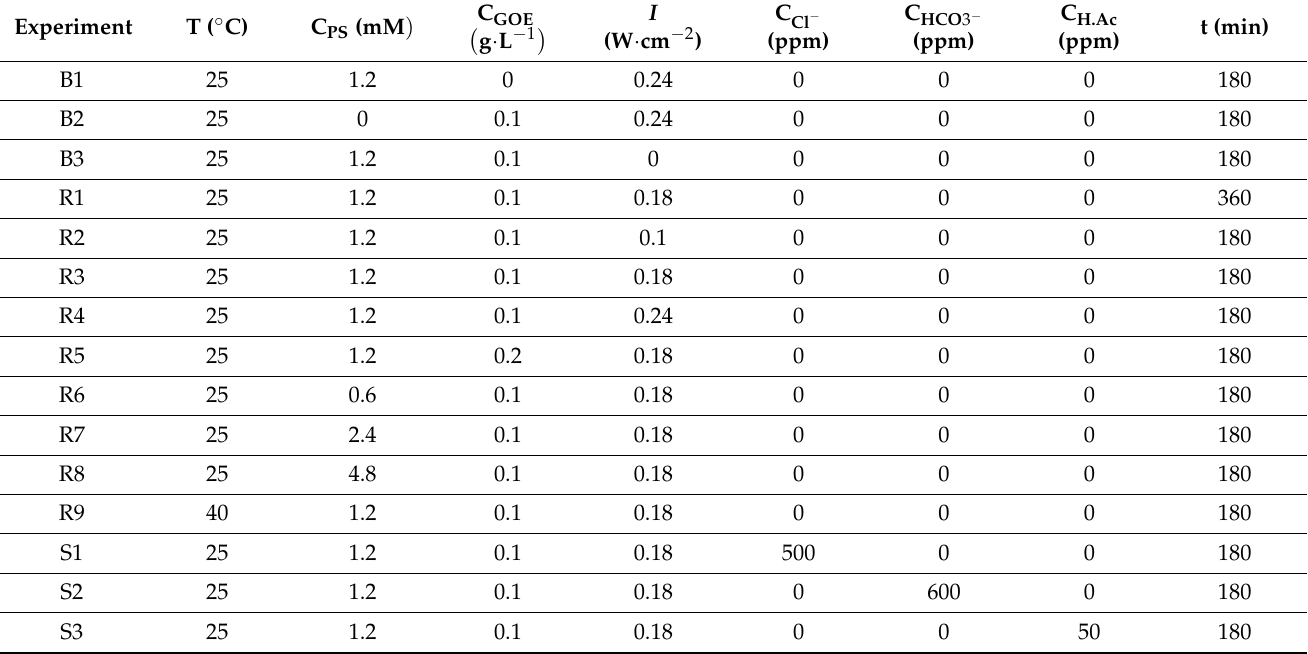
Table 1. Experimental conditions of experiments. Initial NAP concentration 0.1